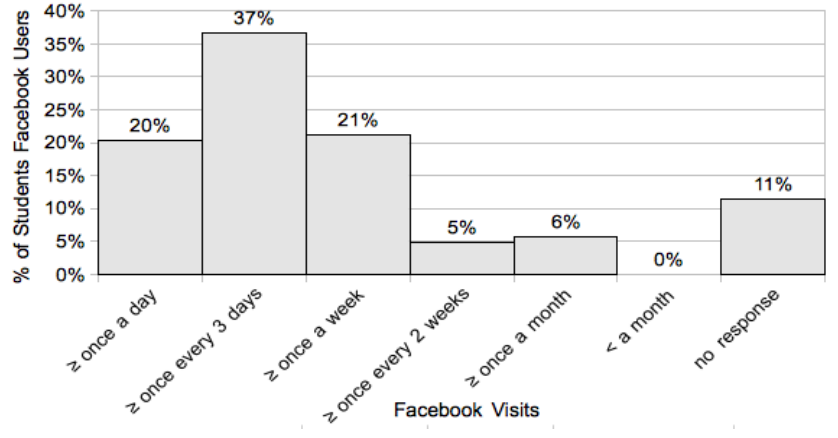
Figure 7. Frequency of Facebook visits.